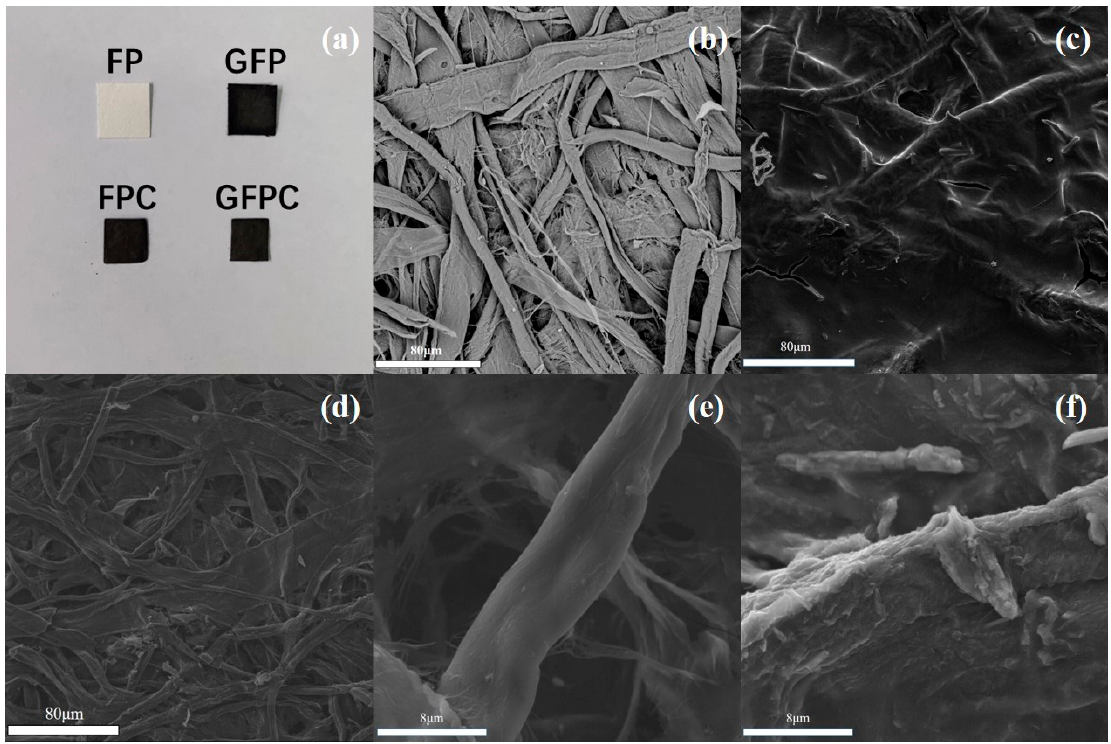
Figure 3. Digital photo image ( a ) and scanning electron microscopy (SEM) images of ( b ) FP, ( c ) GFP, ( d , e ) FPC, and ( f ) GFPC.